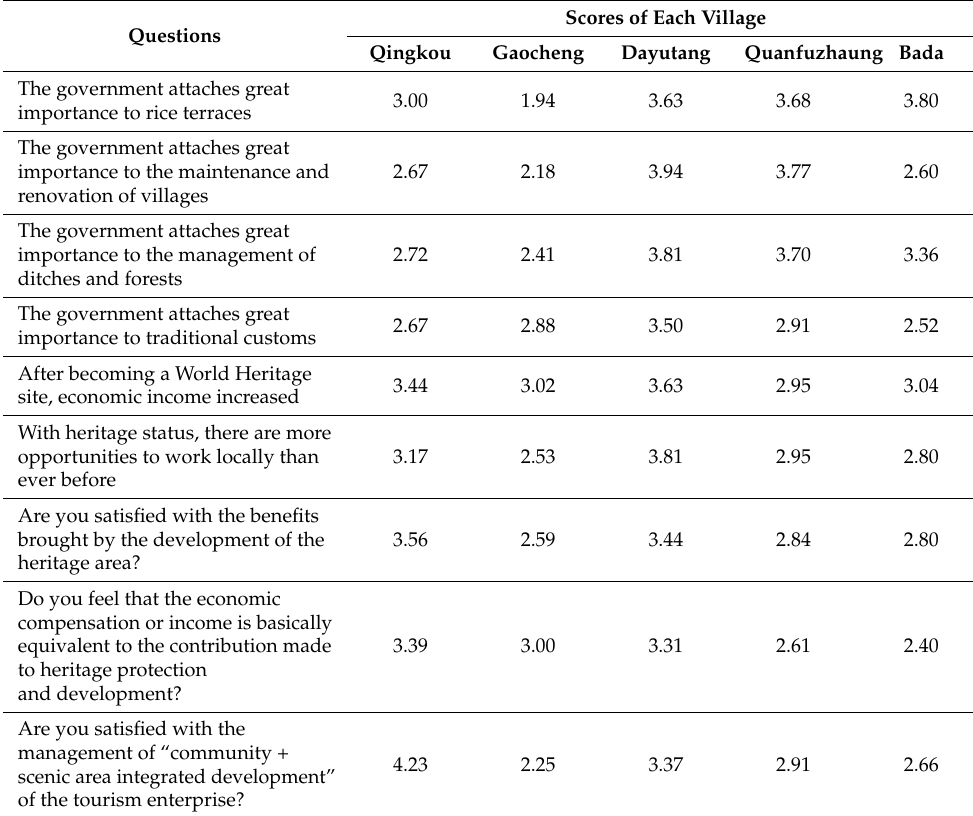
Table 1. Local residents’ perception of conservation. Questions